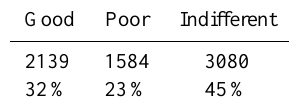
Table 4. Profiles were divided into 3